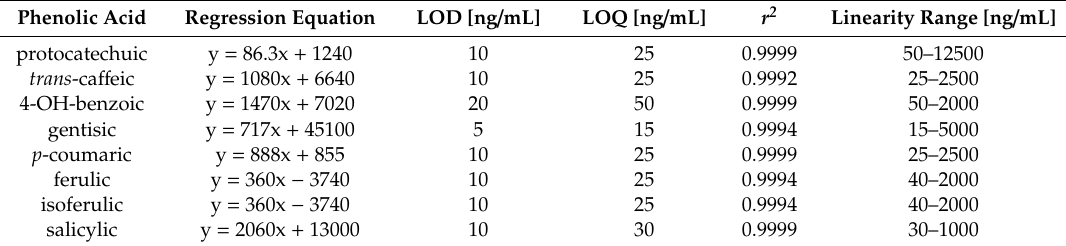
Table 4. Analytical parameters of LC-MS / MS quantitative method; data for calibration curves, limit of detection (LOD) and limit of quantification (LOQ) values for each analyzed phenolic